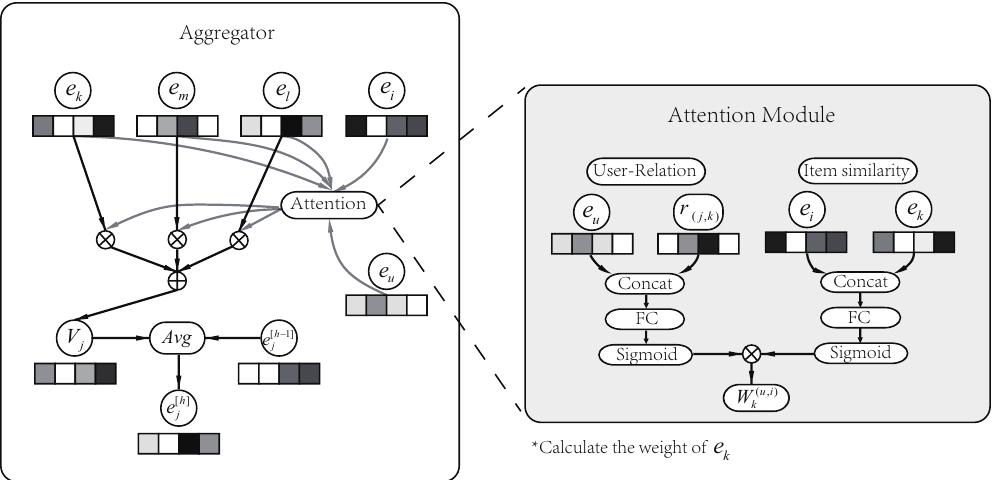
Figure 3. Neighborhood sub-aggregation